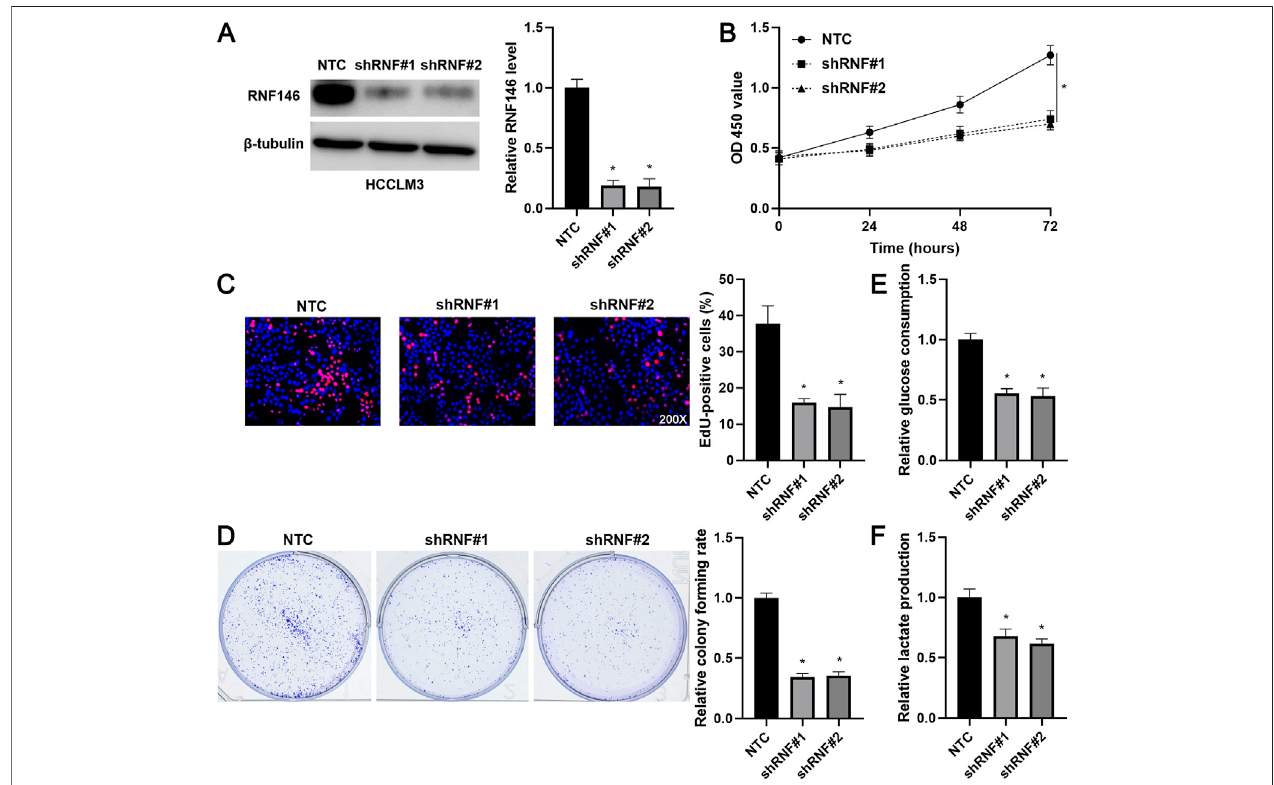
FIGURE 3 | RNF146 knockdown suppresses the proliferation and glycolysis of HCCLM3 cells. (A) The lentivirus-mediated shRNAs targeting RNF146 (shRNF#1 and shRNF#2) and non-targeting shRNA (NTC) were transduced into HCCLM3 cells. WB was performed to determine the RNF146 protein level. (B) RNF146 knockdownreducedtheviabilityofHCCLM3cells. (C) RNF146silencinginhibited theproliferationofHCCLM3cells. (D) Theinhibitoryeffects ofRNF146knockdown on HCCLM3 cell colony formation were con fi rmed. (E) RNF146 silencing reduced the glucose consumption of HCCLM3 cells. (F) HCCLM3 cells ’ lactate production was decreased by RNF146 knockdown. * p <